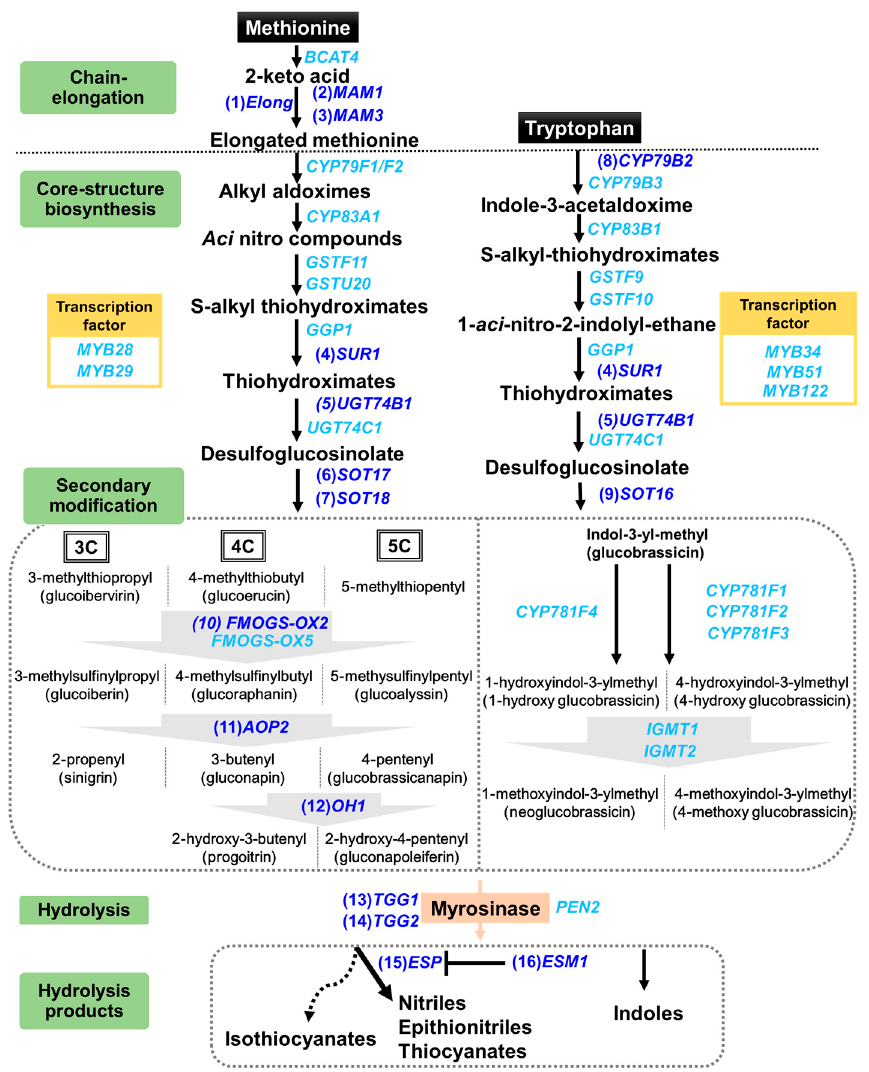
Figure 1. Schematic biosynthetic pathway of aliphatic and indole glucosinolates and involved genes (modified from Yi et al. [16]). Genes following numbers in brackets are analyzed in this study (Table S1). Gene names in light blue without a number were not analyzed in this study. The dashed line separates the biosynthesis pathway into three sections—chain elongation, core-structure biosynthesis, and secondary modification with addition of glucosinolate hydrolysis products. The dashed lines between compounds are to clarify and group the compounds from the same precursor or in the same group. Dotted arrow indicates another reaction pathway without involving of ESP . ESM1 regulates ESP (bar and dash).